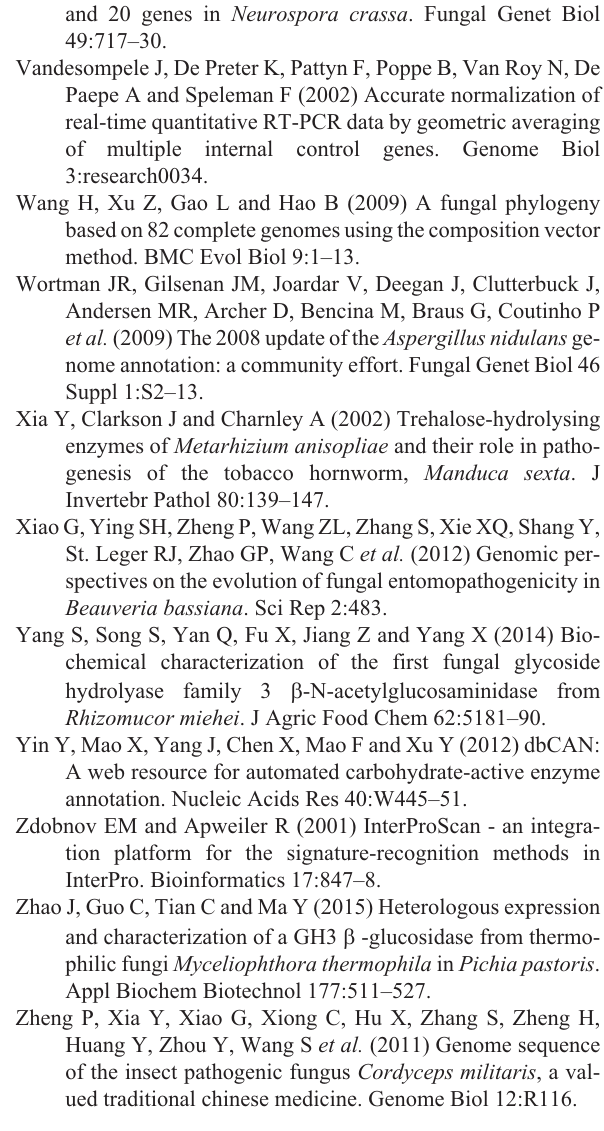
Figure S1 - Major Metarhizium anisopliae cell types in- volved in the cycle of infection. Figure S2 - Multiple alignment of GH20 NAGases from fil- amentous fungi. Figure S3 - MaNAG4 nucleotide and amino acid sequence. Figure S4 - Multiple alignment of GH3 NAGases from bac- teria, zygomycetes, filamentous fungi, and M. anisopliae (cid:2)